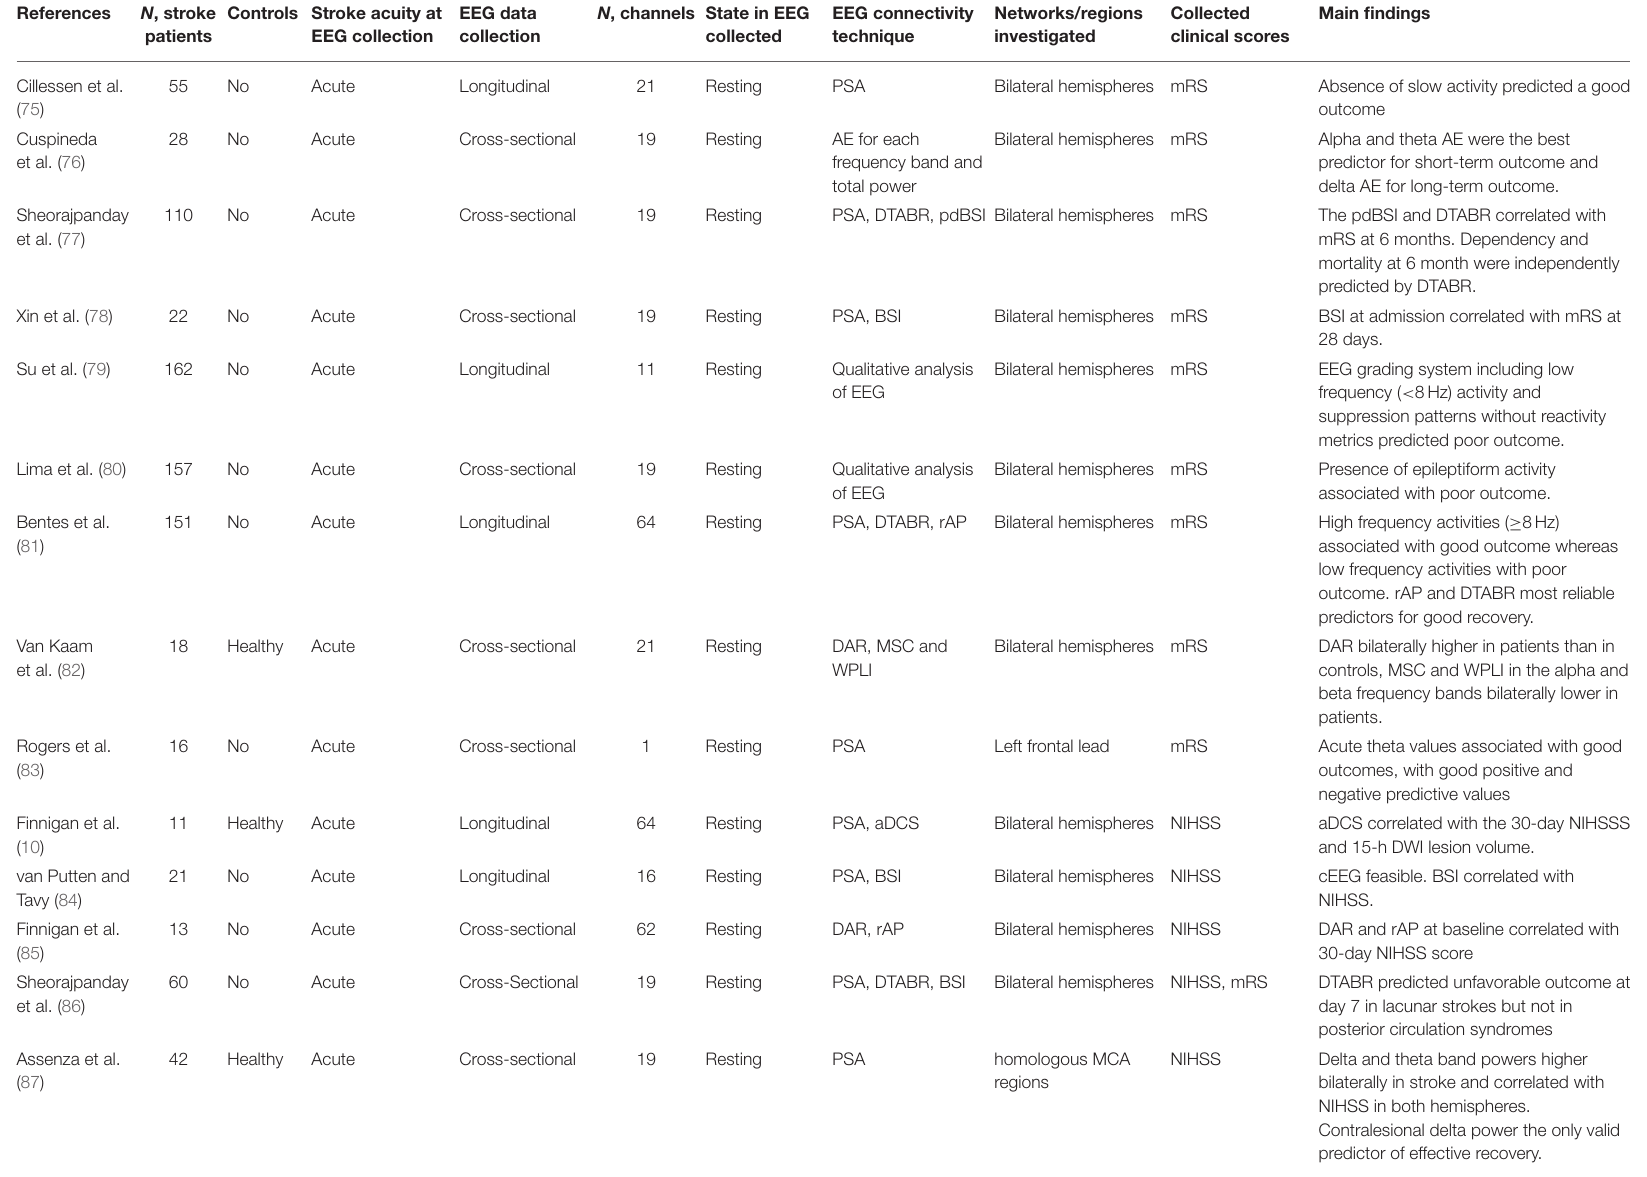
TABLE 4 | EEG studies for functional and global recovery.